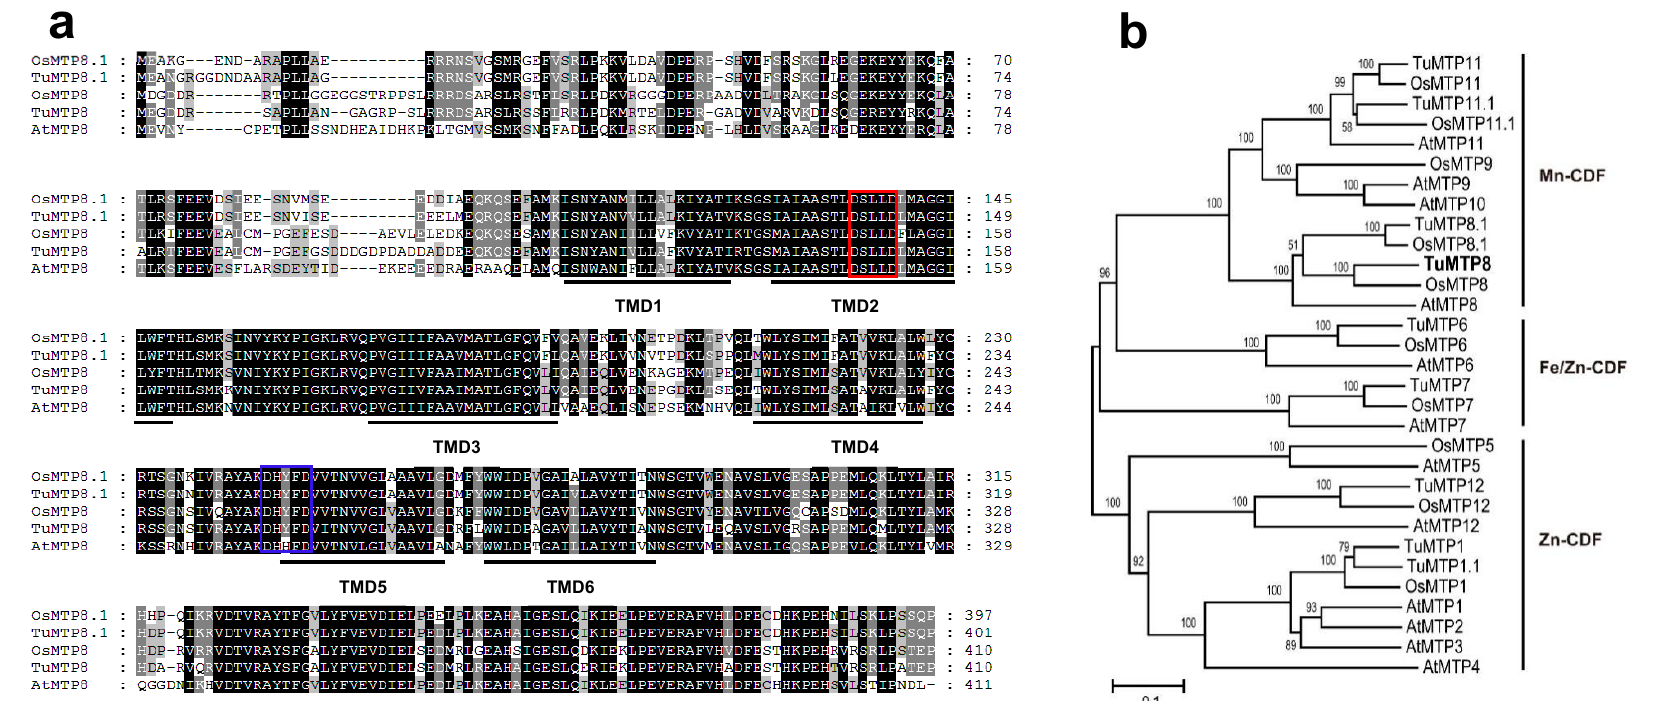
Figure 2. Sequence alignment and phylogenetic relationship analysis of MTP8-like proteins from T. urartu , A. thaliana , and O. sativa. ( a ) The alignment was performed using ClustalW, and visualized using GeneDoc. MTP8-like proteins contain TuMTP8, TuMTP8.1, OsMTP8, OsMTP8.1, and AtMTP8. Identical or similar amino acid residues were represented by black and gray shade, respectively. Red and blue boxes indicate the conserved sequences DSLLDD or DHYFD in TMDs II and V, respectively. ( b ) The neighbor-joining tree was built in MEGA 5.2 with the following parameters: pairwise deletion, p-distance, and 5000 replications. TuMTP8 from T. urartu were highlighted in bold. Accession numbers of all MTP members from T. urartu , A. thaliana , and O. sativa are listed in Table S2.